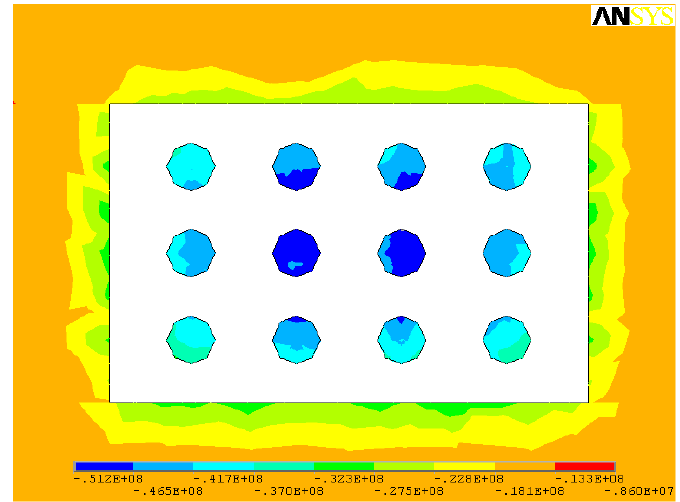
Figure 37. Minimum principal stress distribution of scheme 9 pillars at 1480 mL (parameters of